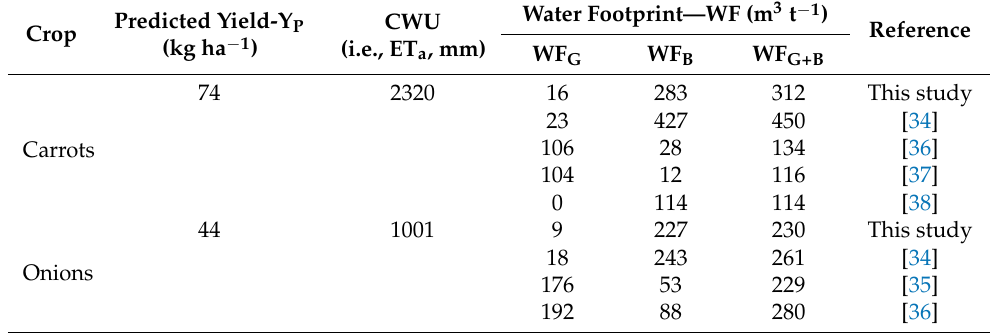
Table 7. Water footprint (WF) of studied crops calculated with SSEB model and published data.